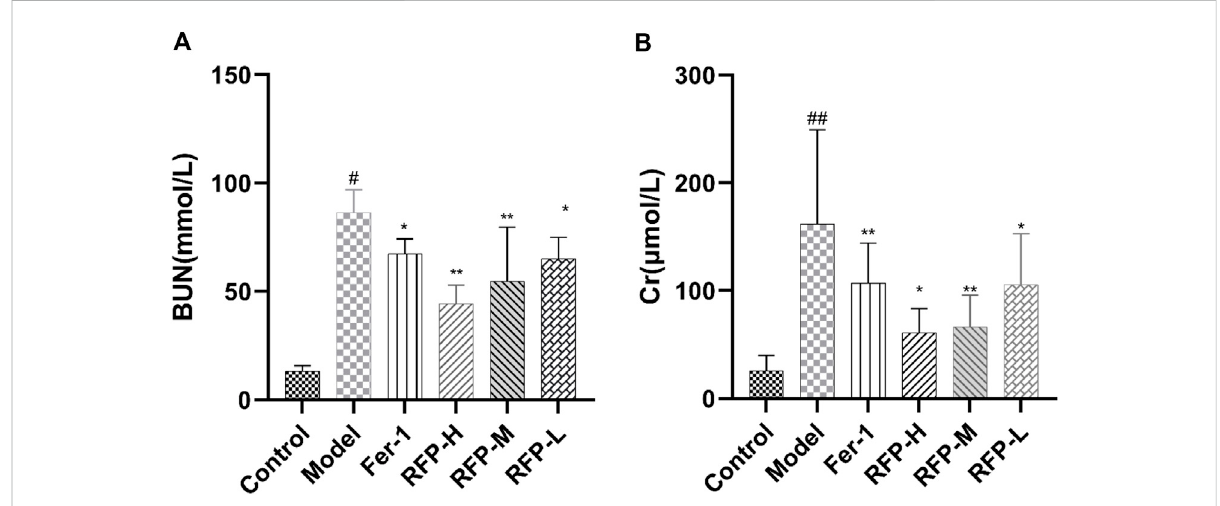
FIGURE 11 EffectofRFPontheserumlevelsofBUNandCrinmicewithcisplatin-inducedacutekidneyinjury. (A) SerumlevelsofBUNindifferentgroupsof mice; (B) Serum levels of Cr in different groups of mice. Data are expressed as mean ± SD (n = 8), * p < 0.05, ** p < 0.01as compared to the model group, ## p < 0.01 as compared to the blank group.